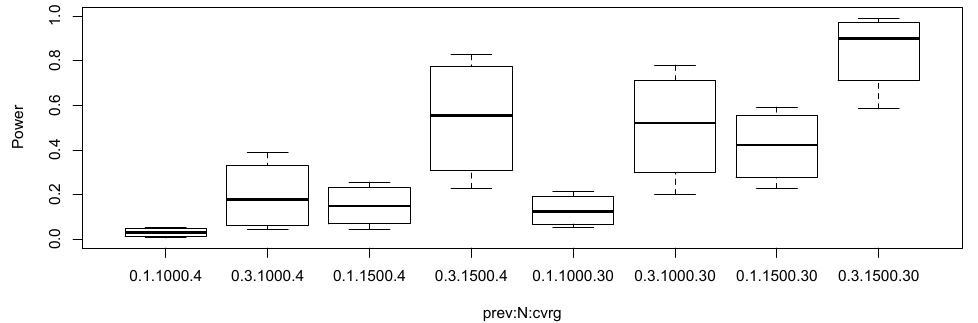
Figure 2. Boxplots of statistical power of the proposed robust test under the alternative settings. The level of significance was set as 5 × 10 − 8 . The notation 0.1.1000.4 represents prevalence 0.1, total sample size 1000, and coverage 4 ×